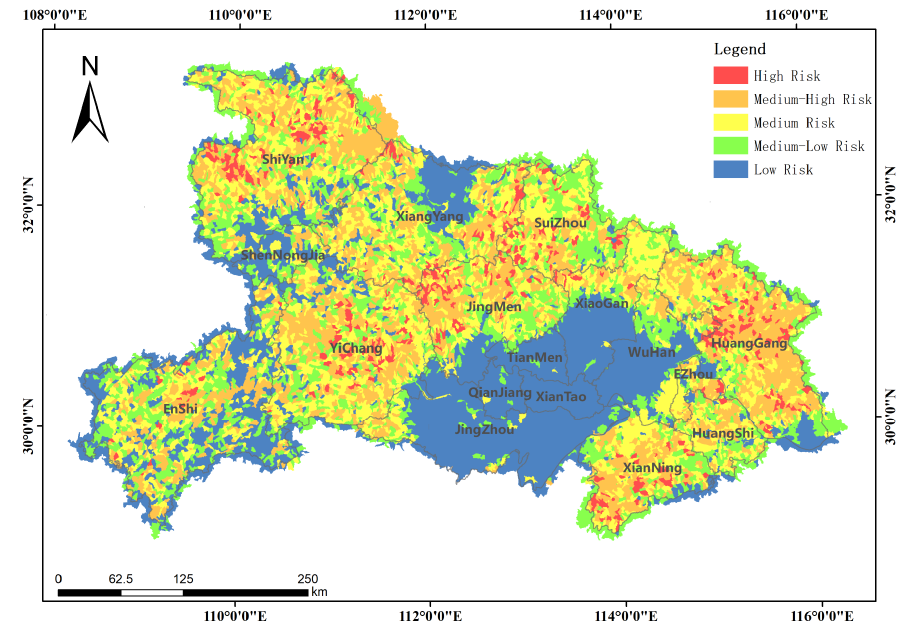
Figure 9. Risk Distribution of Flash Floods in Hubei Province. Table 14. The Proportion of Risk Areas of Different Levels in Each City.